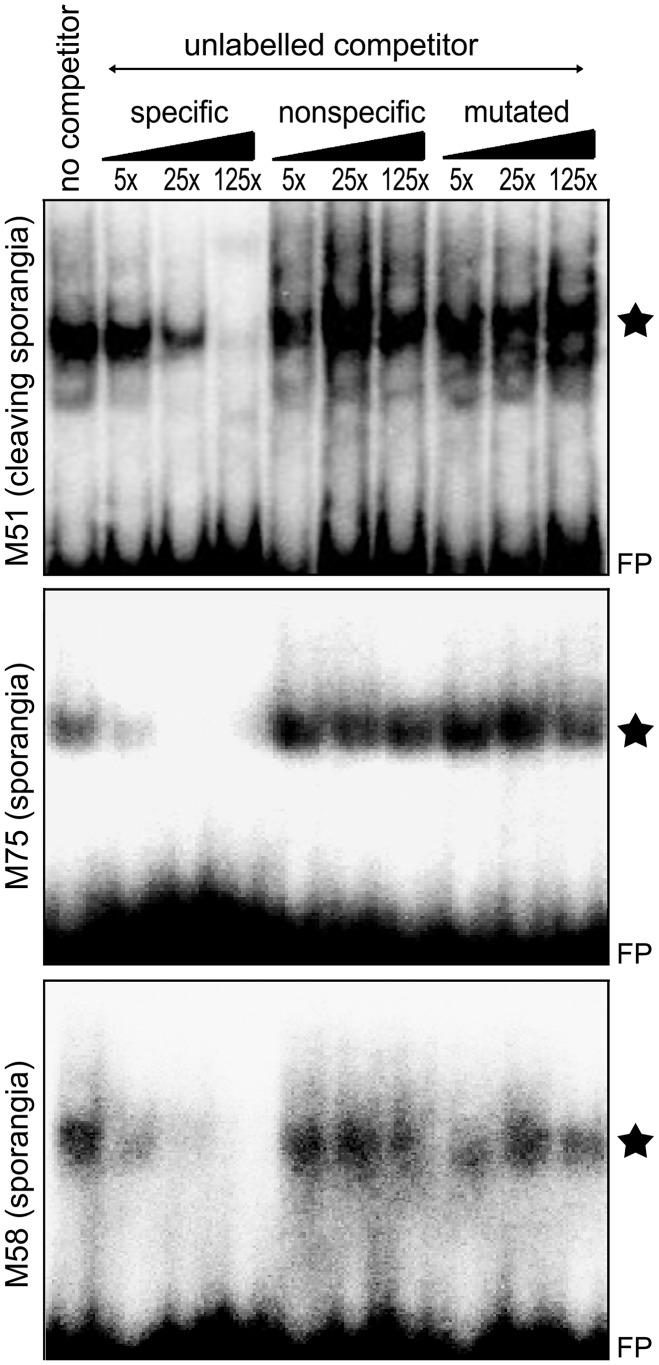
Electrophoretic mobility shift assays.Nuclear proteins from cleaving sporangia or sporangia were mixed with 32P-labeled double-stranded oligonucleotides containing M51, M75, and M58, and subjected to electrophoresis. Reactions were performed either with no competitor, or unlabeled competitors at 5×, 25×, and 125× the concentration of labeled probe. These were either a specific competitor (same as labeled probe), a nonspecific competitor containing unrelated sequences, or mutated competitors derived from the specific competitor but mutated for the motif. Stars indicate the specific bands, and FP stands for free probe.